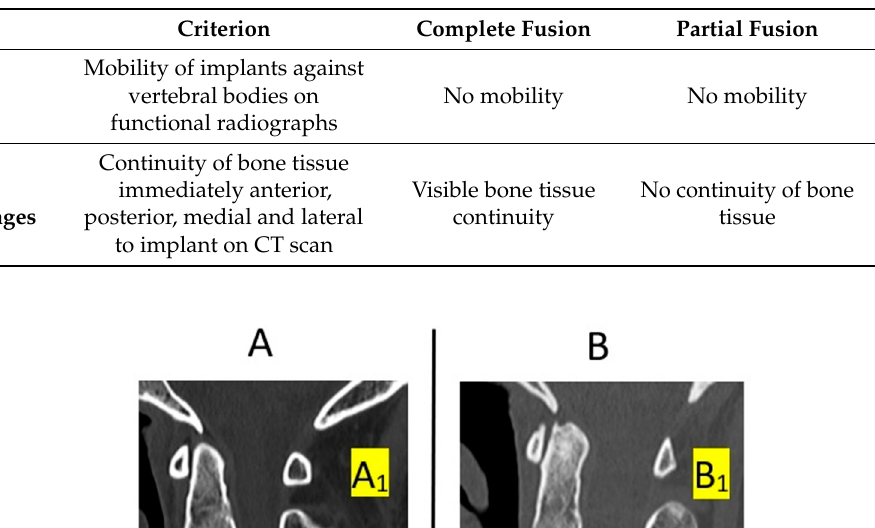
Table 1. Criteria for evaluation of fusion based on CT scans and functional conventional radiographs of cervical spine at 12 months post-surgery. Reprinted by permission from Springer Nature: Acta Neurochirurgica 2022, 164 (6), 1501–1507. PEEK versus titanium-coated PEEK cervical cages: fusion